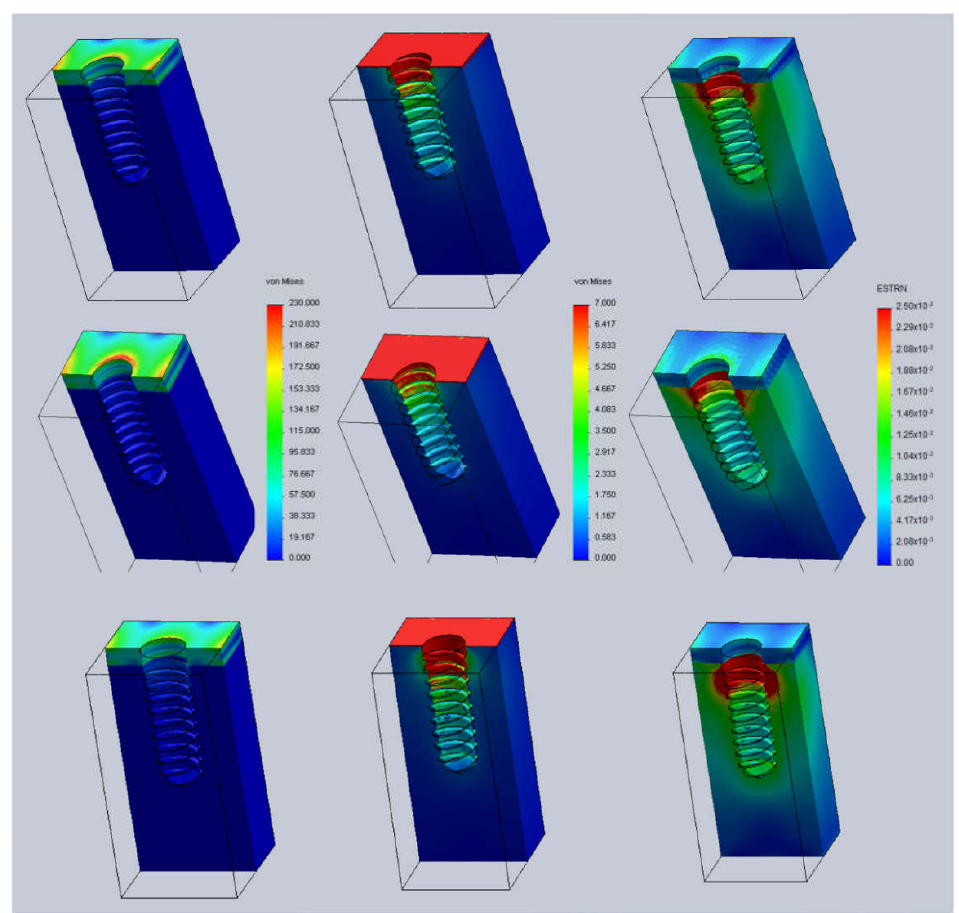
Figure 6. Von Mises stresses and strains with a cortical-bone thickness of 1.5 mm. Left column: stresses at cortical bone. Center column: stresses at trabecular bone. Right column: strains. Top row: Case A (h = +0.5). Middle row: Case B (h = 0). Bottom row: Case C (h = −0.5).